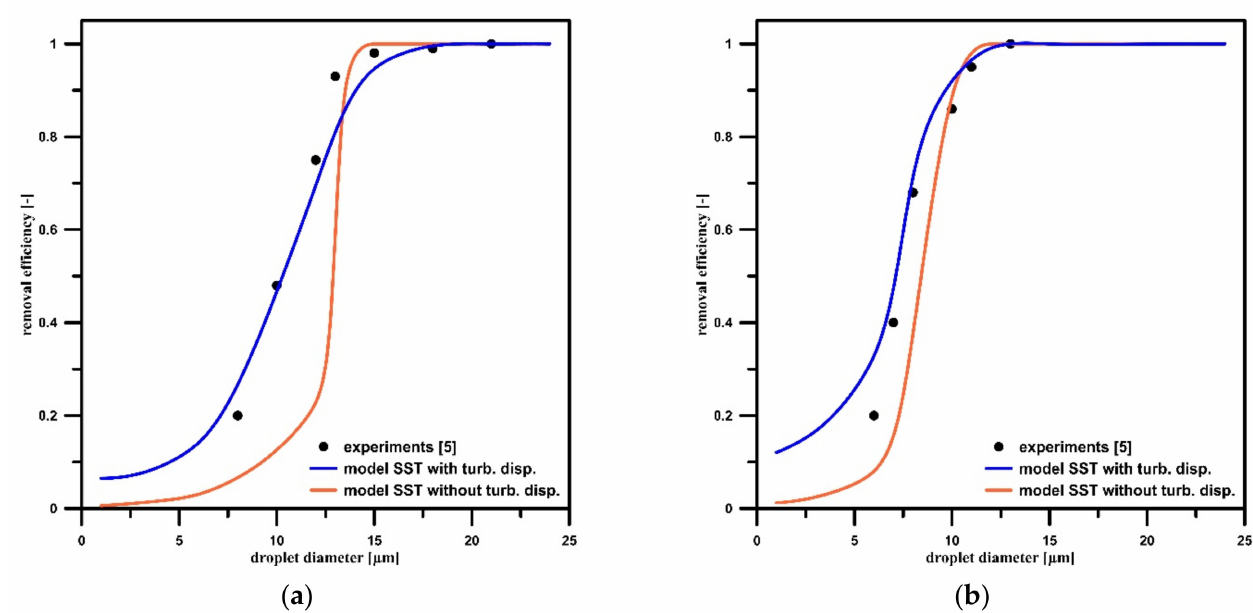
Figure 6. Comparison of calculated results obtained with SST model with and without using turbulent dispersion with experimental data for geometry B_10_0 with inlet velocity: ( a ) 2 m s − 1 ; ( b ) 4 m s − 1